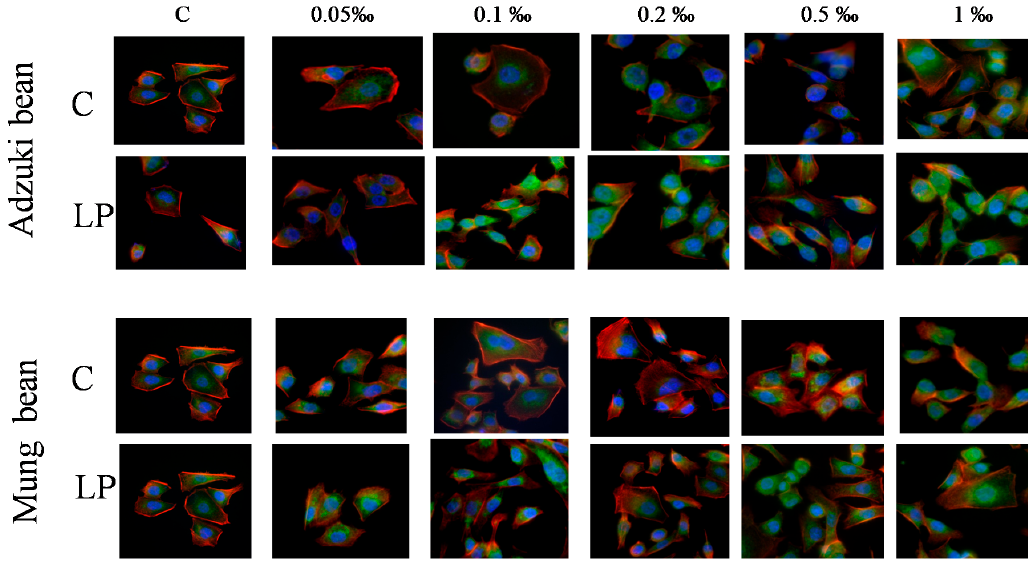
Figure 4. Effects of the control (C) and L. plantarum -fortified sprout extracts (LP) on the actin cytoskeleton architecture of human gastric cancer (AGS) cells. Actin—red, vinculin—green, and DNA—blue.